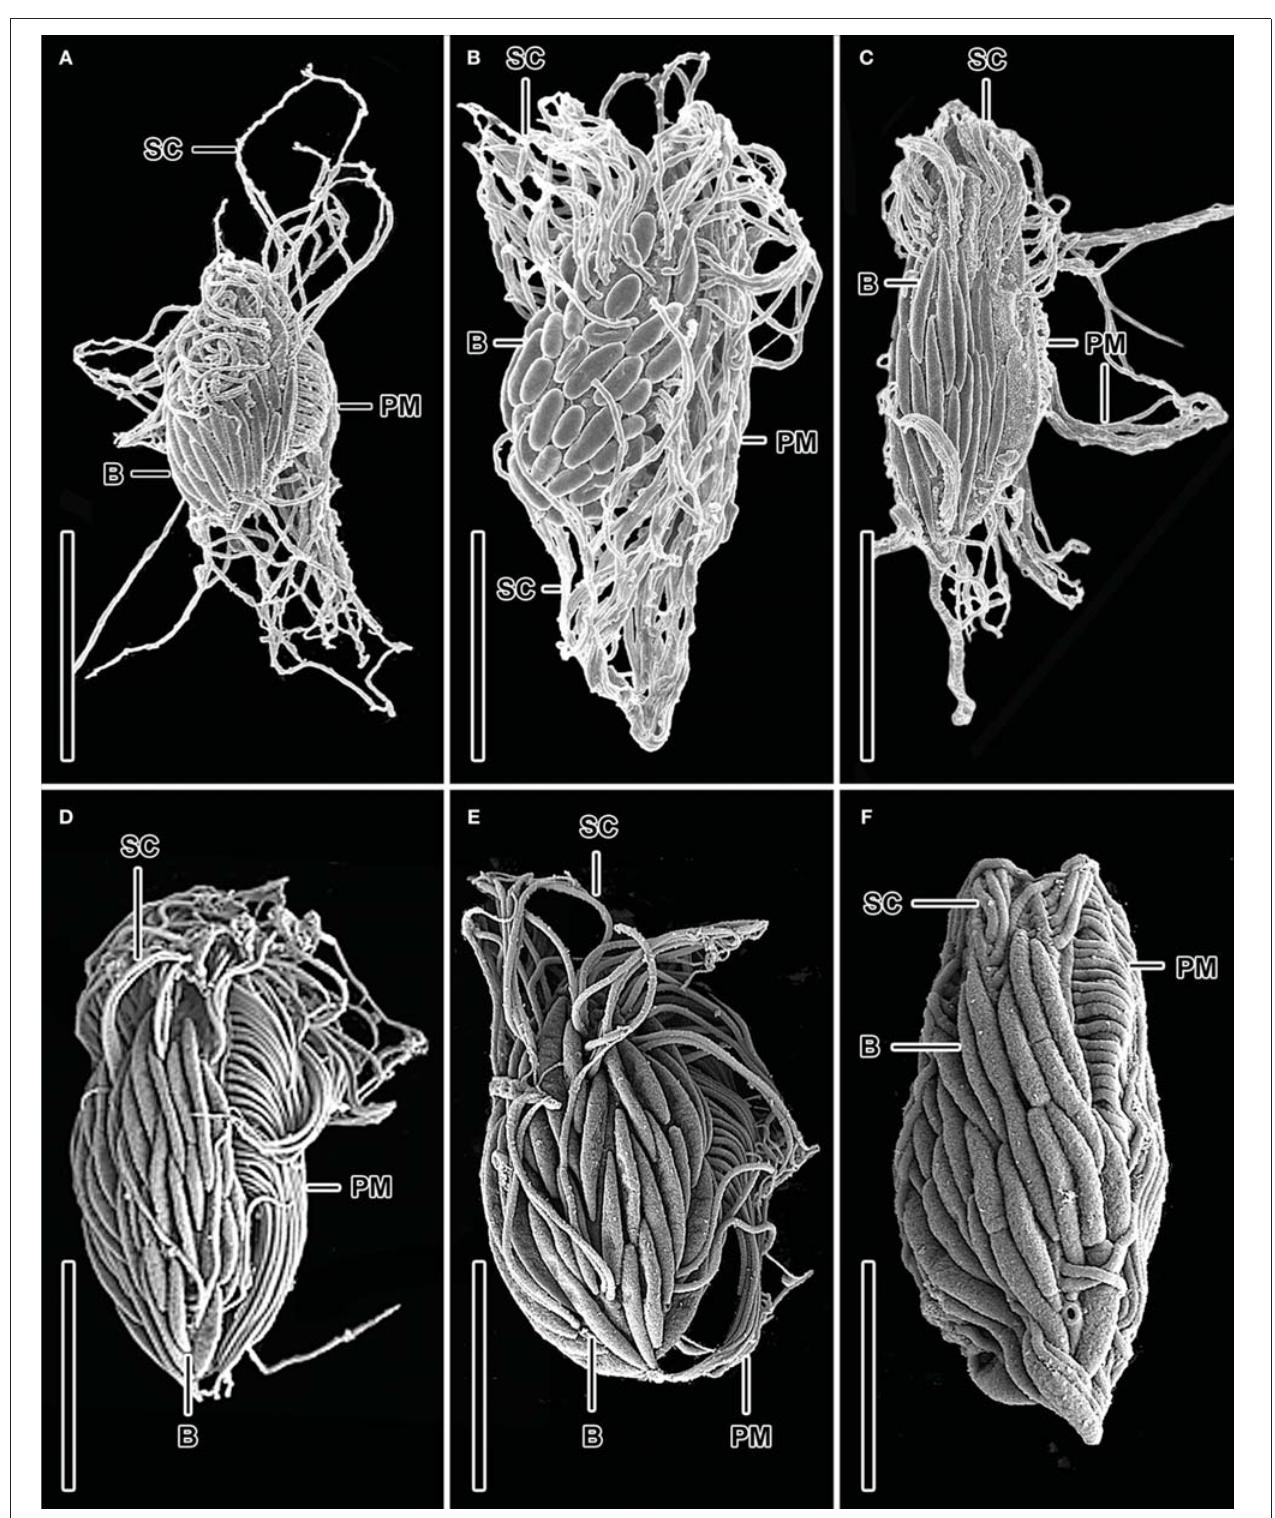
FIGURE 1 | SEM micrographs of various bacteria/ciliate morphologies from the CariacoBasin intheCaribbeanSea(A–C)andthehaloclineofthe Urania Basin in the Mediterranean Sea (D–F). Dorsolateral (A, B, D–F) and dorsal (C) views of possible scuticociliates exhibiting epibiotic Bacteria which